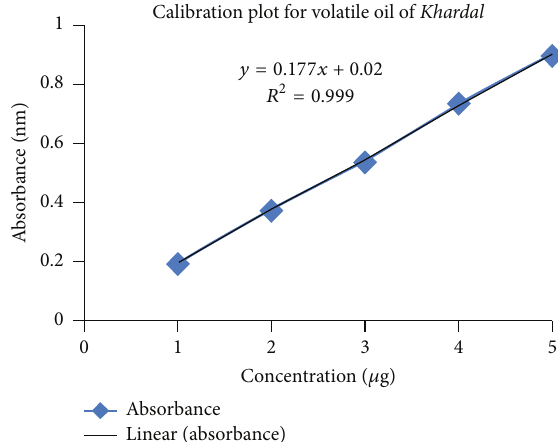
Figure 1: Calibration curve of volatile oil of Khardal .